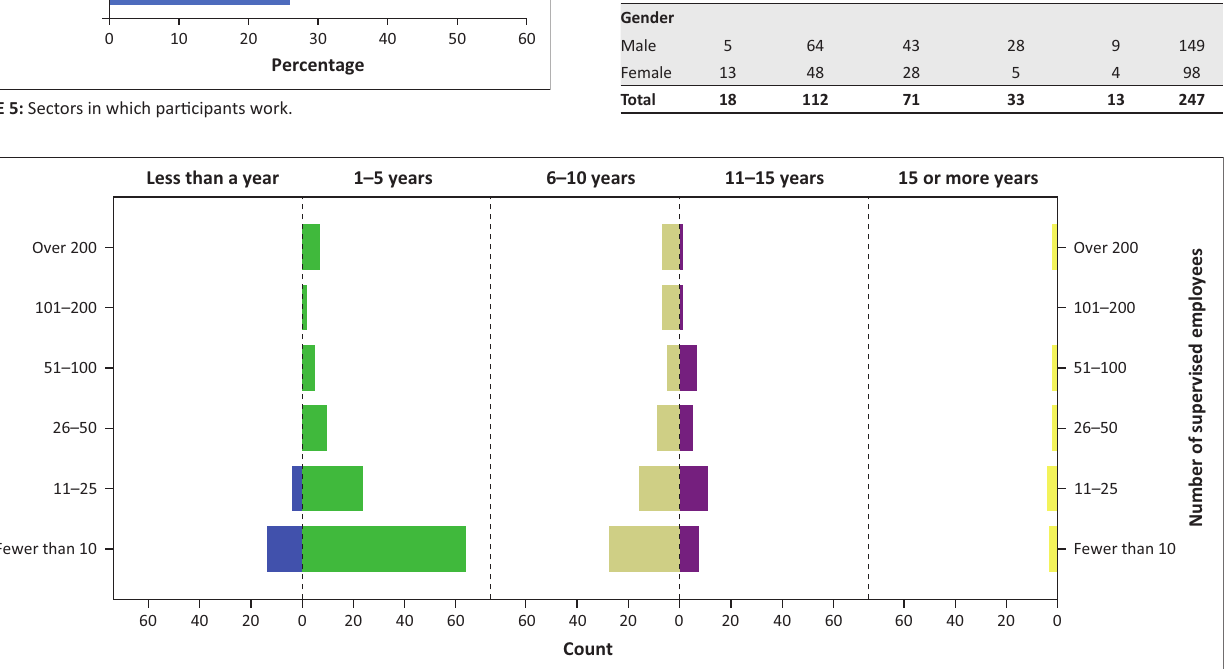
FIGURE 6: Experience of participants in a leadership position.